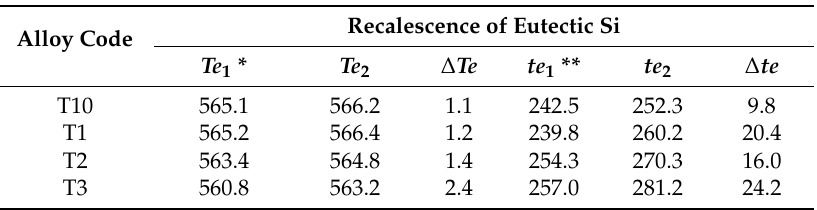
Figure 4. ( a ) Solidification curves of La+Sr-containing alloys; ( b ) solidification curves of Ce+Sr-containing alloys. Table 3. Effect of La addition on the recalescence of the eutectic Si.